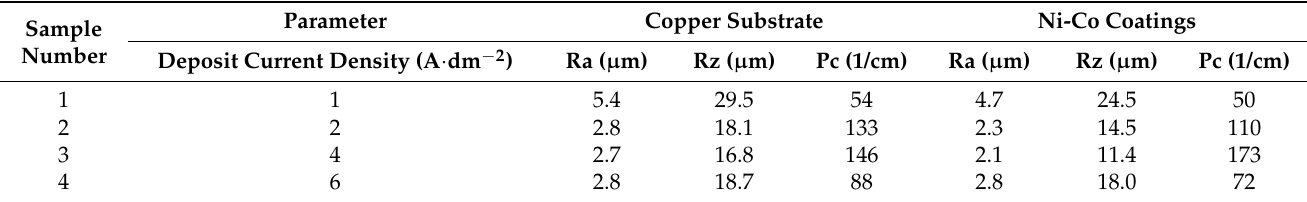
Table 3. Micro geometrical characteristics of copper substrate and Ni-Co coatings.